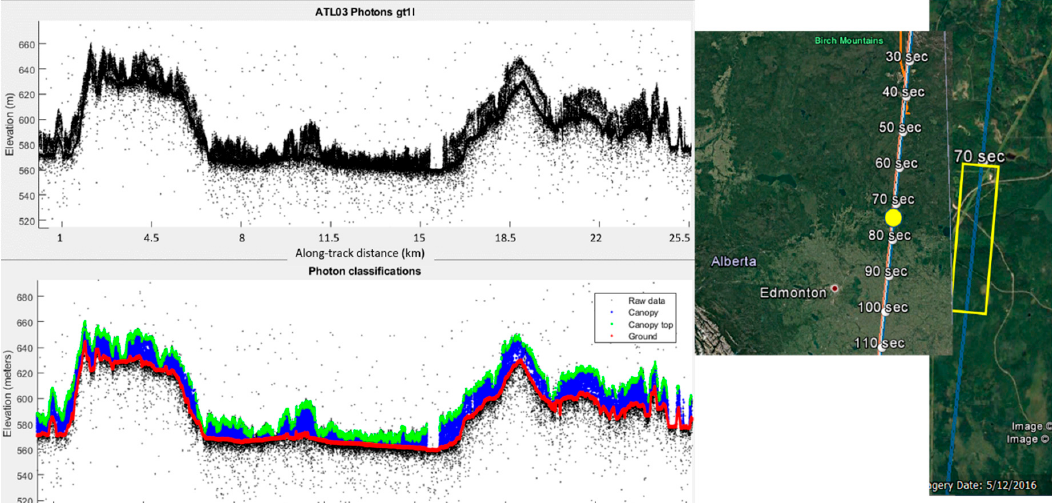
Figure 4. Top panel. Profile of 25 km of ATL03 photons from strong beam (GT1L) over boreal forest northeast of Edmonton, Alberta. These data were collected on 21 February 2019 during the night, as evidenced by the relatively low number of noise photons above the surface signal photons. The bottom panel is the result of the ATL08 algorithm surface classification labels for ground photons (red), intermediate canopy photons (blue), and top of canopy photons (green) The panel to the right depicts the location of the ICESat-2 track in Google Earth for context [14,16].